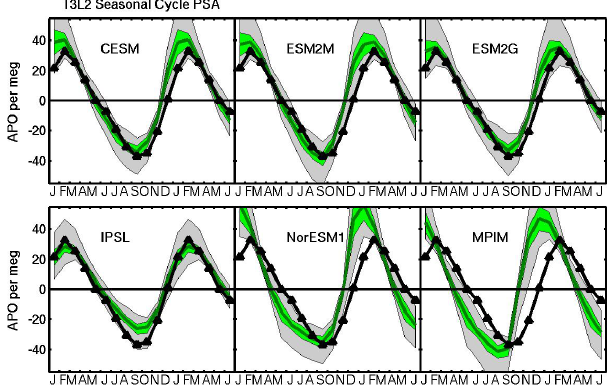
Figure 2d. Results at Barrow, Alaska (71.3 ◦ N, 156.6 ◦ W), com- pared to PU observations.